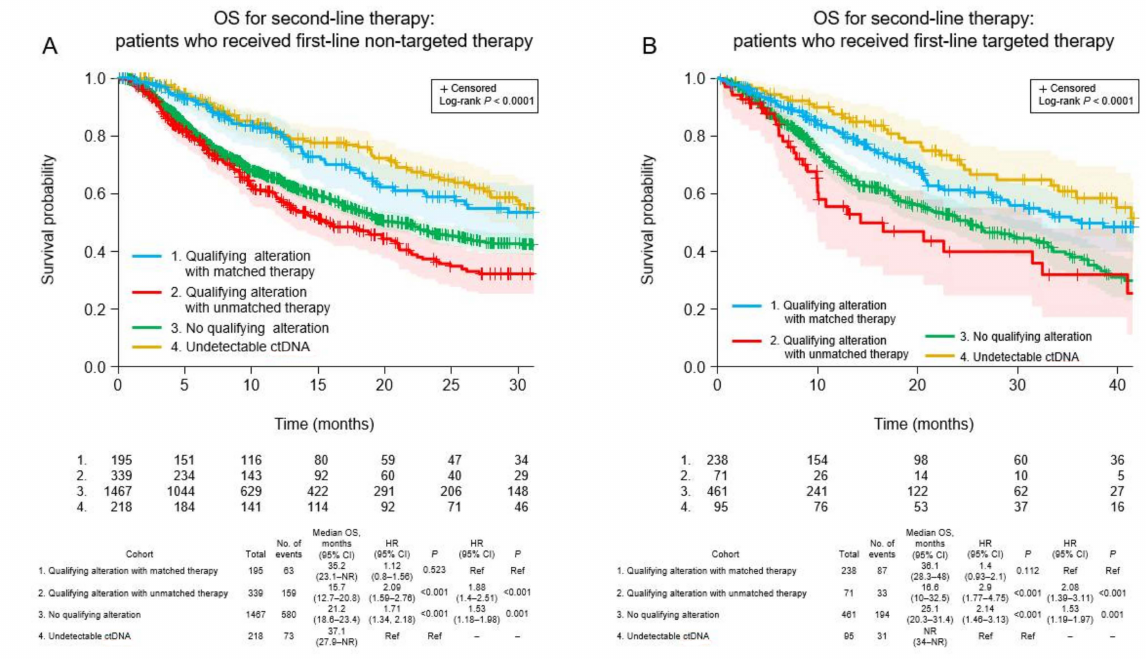
Figure 4. Overall survival after second-line ctDNA testing in the four patient cohorts according to whether the first-line therapy was non-targeted ( A ) or targeted ( B ). CI, confidence interval; HR, hazard ratio; NR, not reached; OS, overall survival; Ref,